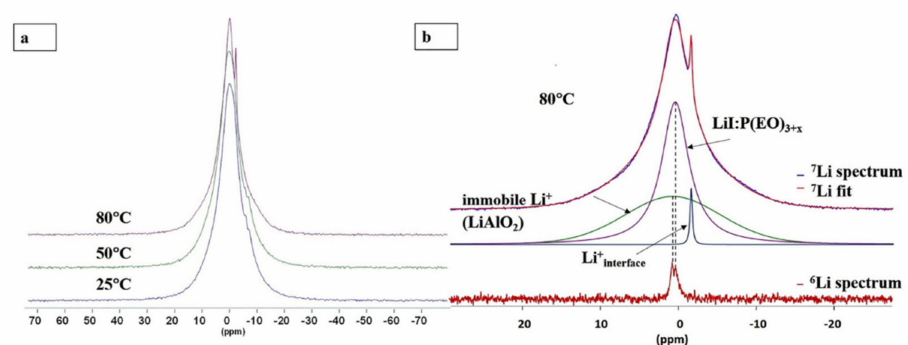
Figure 12. Variable temperature 7 Li NMR spectra (7.1 T, 5 kHz) of a PEO-LiI polymer matrix containing LiAlO 2 ( a ). Deconvolution of the spectrum at 80 ◦ C ( b ). Reprinted from [101]. Copyright 2019 with permission from